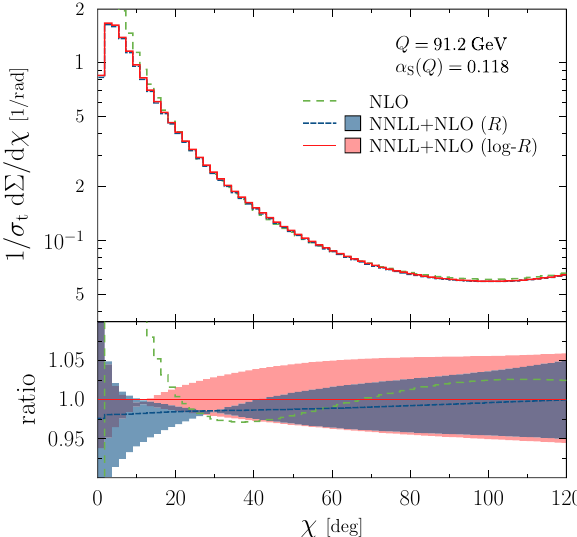
Fig. 3 NNLL + NLO matched predictions for EEC using R and log- R matching. The bottom panel shows the ratio of the fixed-order NLO and R matched predictions tothe log- R matchedresult. The bands represent renormalization scale variation of the matched predictions in the range μ ∈ [ Q / 2 , 2 Q ] with two-loop running of α S ) term in Eq. (3.13). We simply by dropping the O (α 3 S